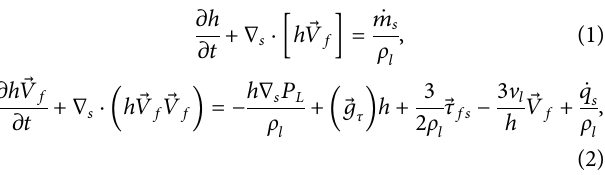
Frontiers in Chemical Engineering |